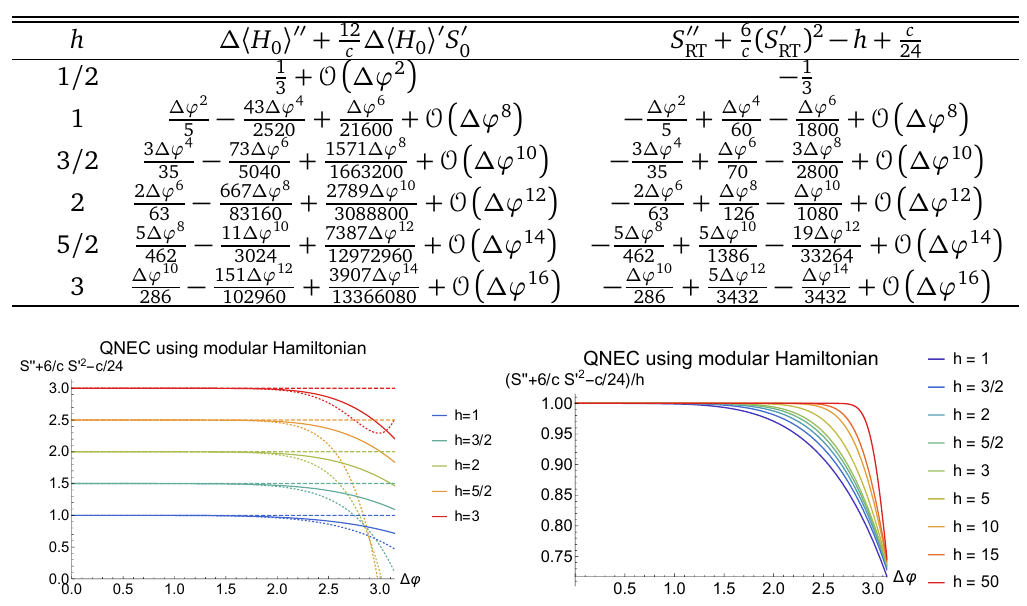
Table 1: All leading terms in a small ∆ ϕ expansion cancel